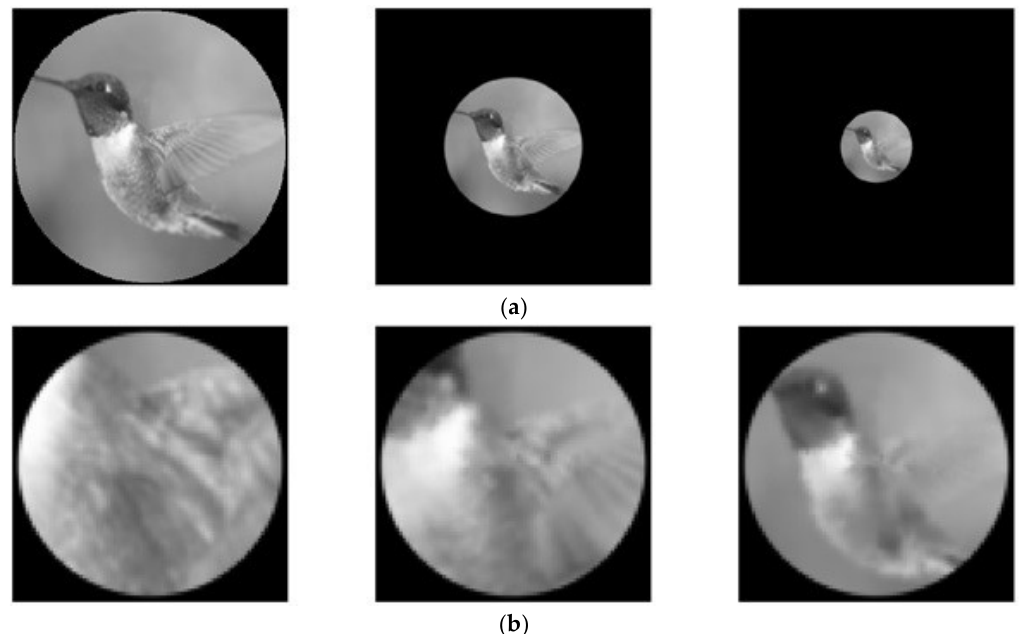
Figure 11. Illustration of a foveal scale space generated using the log-polar transform. ( a ) Image in “native” cartesian coordinates wherein the shrinking of the image from left to right illustrates how it moves towards the center of the image through scale space; ( b ) Foveal region corresponding to images in ( a ) showing how the support of the foveal region grows with increasing scale.